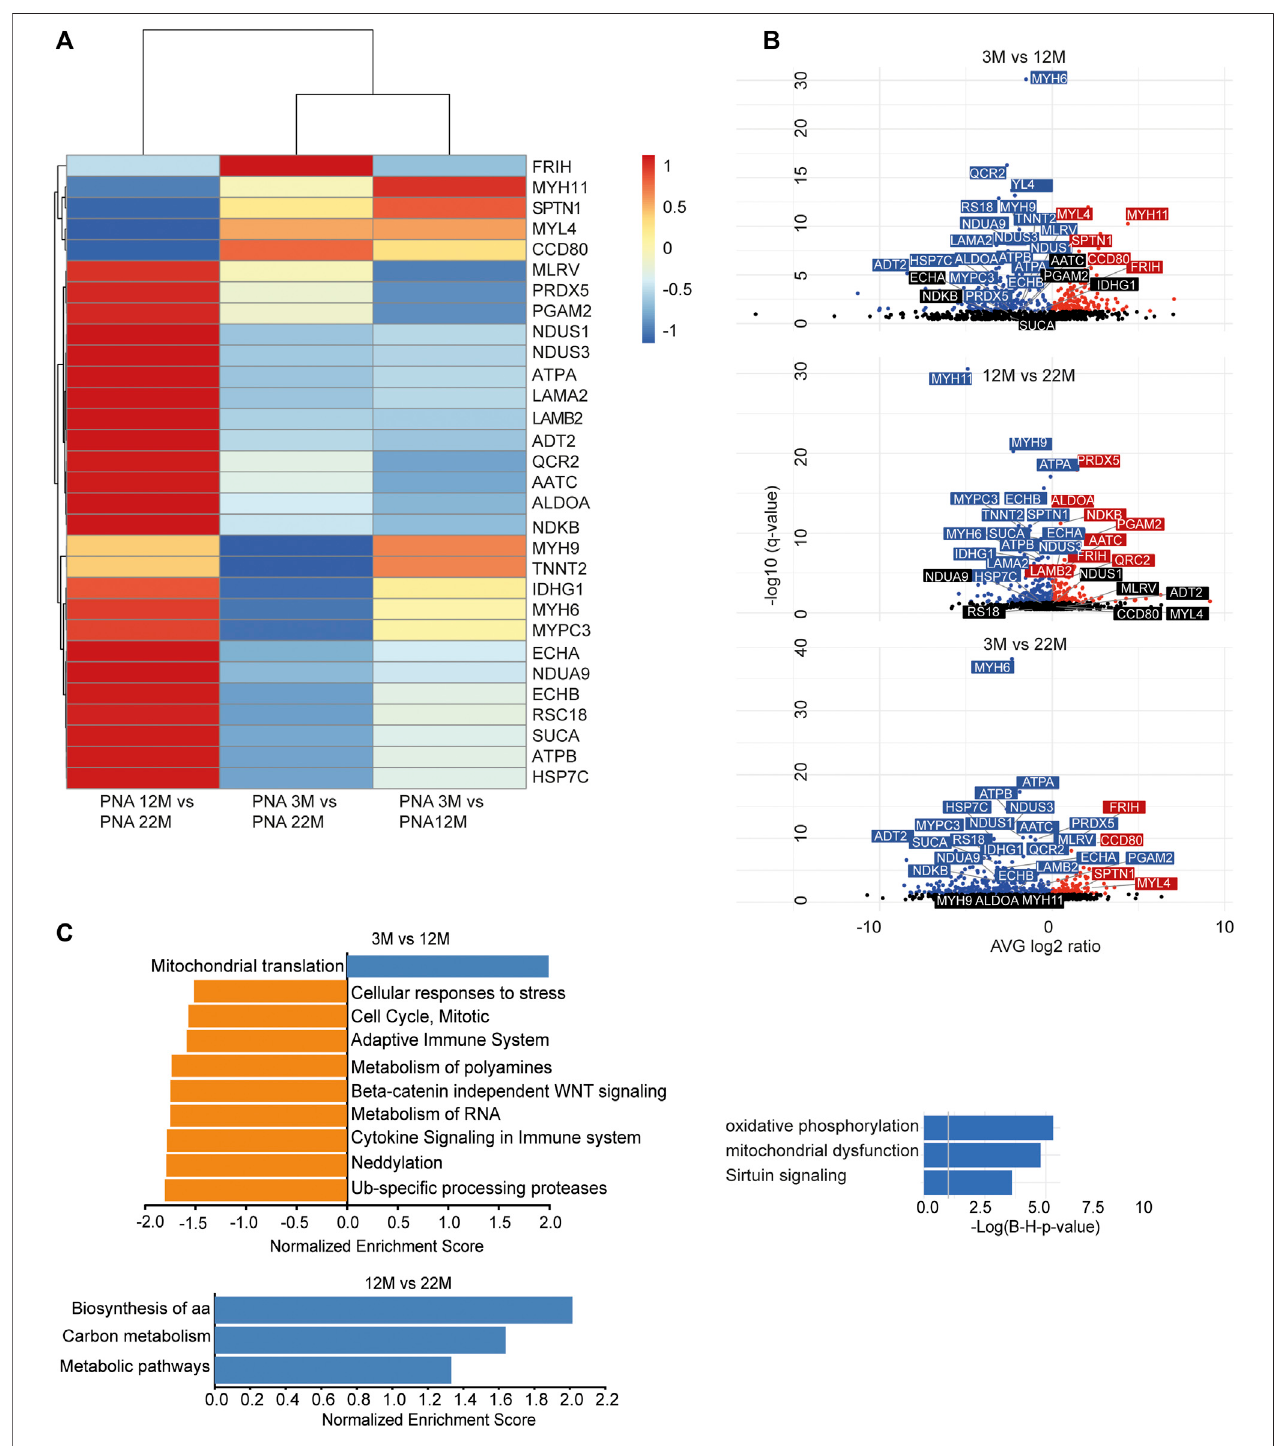
FIGURE 5 | Quantitative changes in the cardiac glycoproteome during aging upon PNA pull-down. (A) Mass spectrometry analysis of top 30 cardiac muscle proteinsofagingmalemiceafterPNApull-down.Proteinssigni fi cantlyup-regulated/orhyperglycosylatedbetweentwodifferentagesareshowninredandthosedown- regulated/or hypoglycosylated in blue ( n (cid:2) 3 mice per age). (B) Volcano plots for all identi fi ed proteins after PNA enrichment with a q-value below 0.05. Proteins signi fi cantly up-regulated/or hyperglycosylated between two different ages are shown in red and those down-regulated/or hypoglycosylated in blue, while unchangedproteinsareshowninblack( n (cid:2) 3miceper age). (C) AffectedpathwaysareshownforPNA(glycanscarryingterminalgalactose)enriched proteins. Geneset expression analysis (GSEA) showing reactome with a false-discovery rate (FDR) of < 0.05. Up-regulated/or glycosylated GSEA reactome pathways are shown in blue, down-regulated/or -glycosylated GSEA reactome pathways are indicated in orange. Most affected pathways identi fi ed by ingenuity pathway analysis (IPA) (FDR < 0.1).